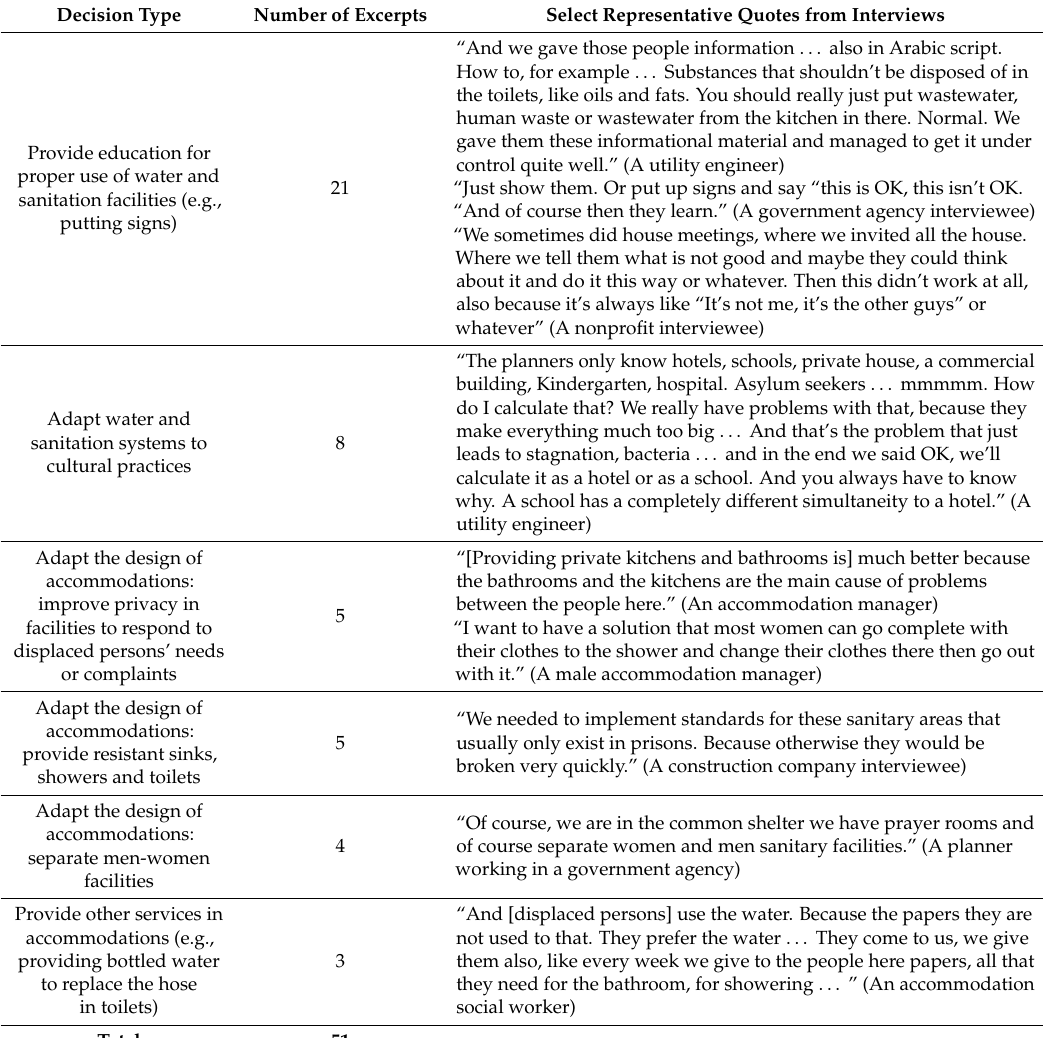
Figure 4. Entrance of a lavatory room with signs posted by a centralized accommodation manager after noticing that select displaced persons were using sinks as showers. Table 5. Frequency of the types of decisions made by the interviewees while legitimizing the inclusion of cultural practices.